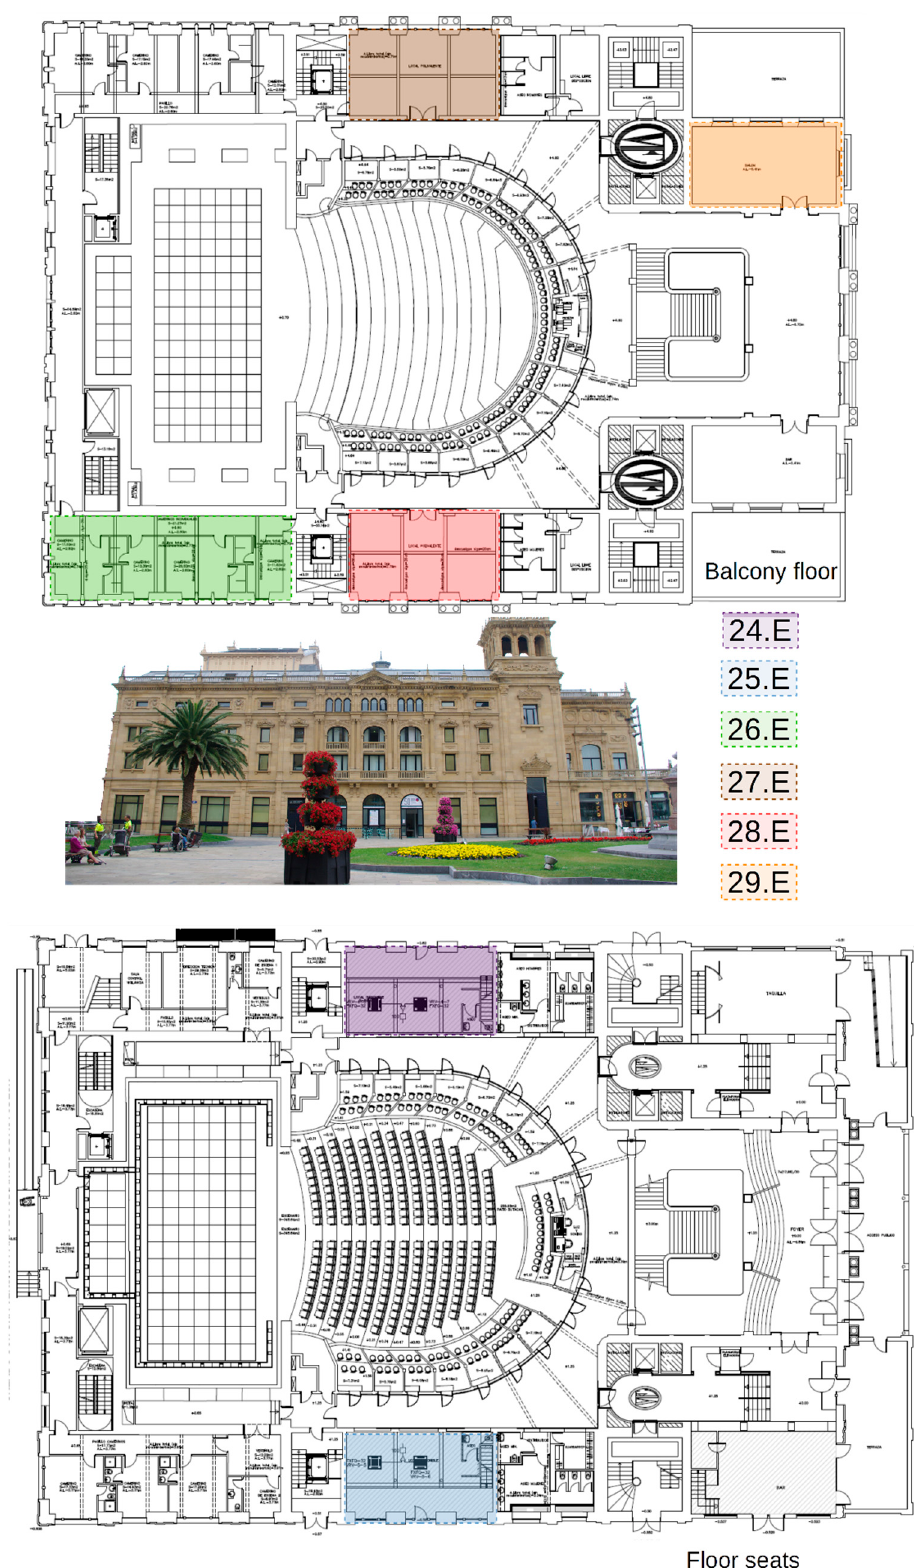
Figure A5. Floor plans of the blower door tests performed in the Victoria-Eugenia Theatre case study.